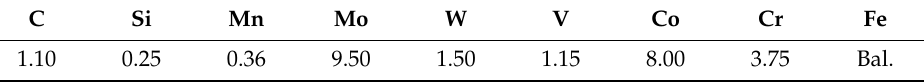
Table 1. Element contents of M42 High-Speed Steel (wt